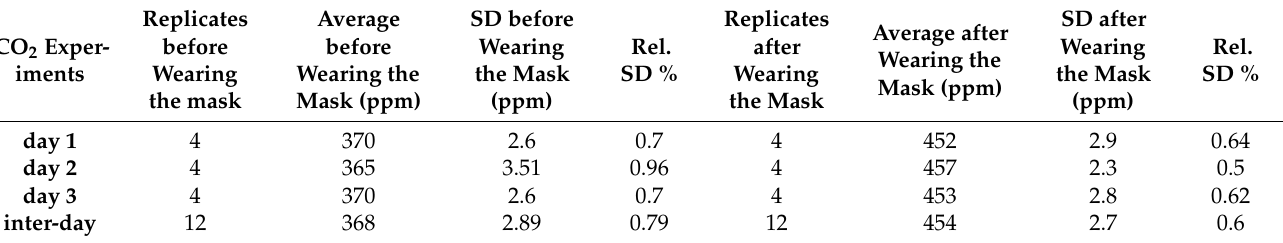
Table 2. Intra- and inter-day repeatability: carbon dioxide measurements.